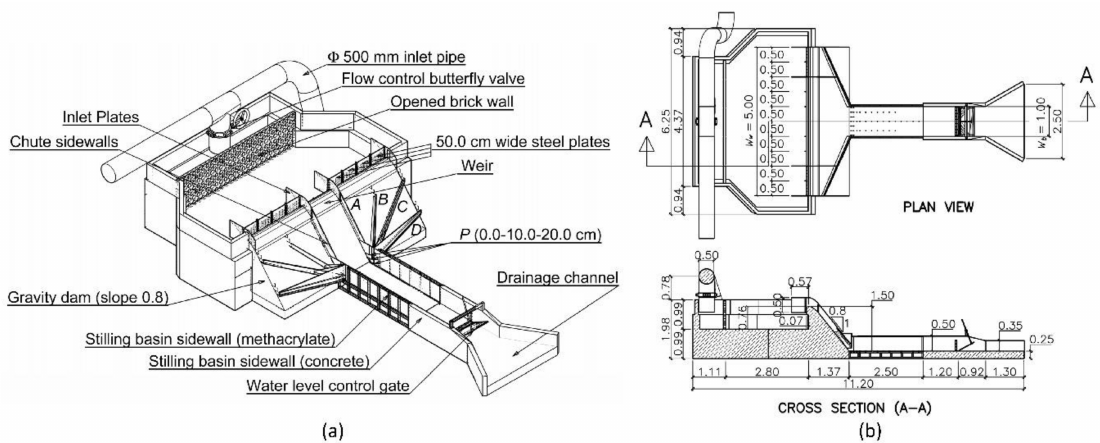
Figure 2. Experimental facility: ( a ) 3D scheme with the main parts and the setup configurations A , B , C and D , and ( b ) plan view and longitudinal